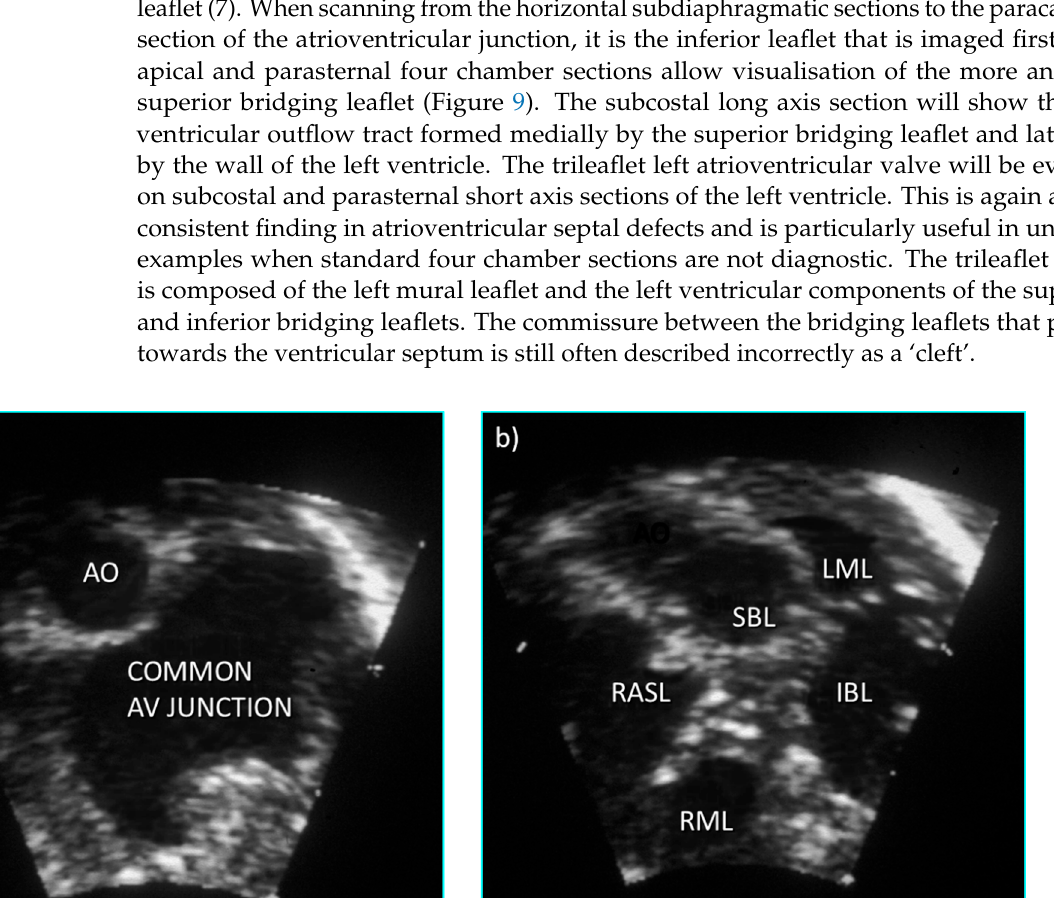
Figure 5. Subcostal left oblique short axis echocardiographic section of AV junction at level of AV valve leaflets showing ( a ) common atrioventricular valve during atrial systole and ( b ) the zone of apposition of the superior and inferior bridging leaflets.